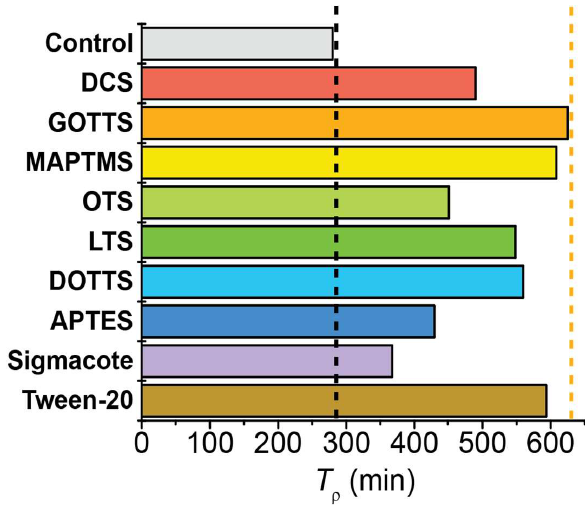
Figure 6. Plot comparing the pH 2 T  values for a valved NMR tube coated with different surfactants. All surfactants provided longer T  values than the control (uncoated glass), with some doubling the control’s T  value. Vertical black dashed line marks the T  value of the control; vertical orange dashed line marks the longest T  value observed. Supplemental Figure S4 plots this data grouped by surfactant category (e.g., small, medium, long,